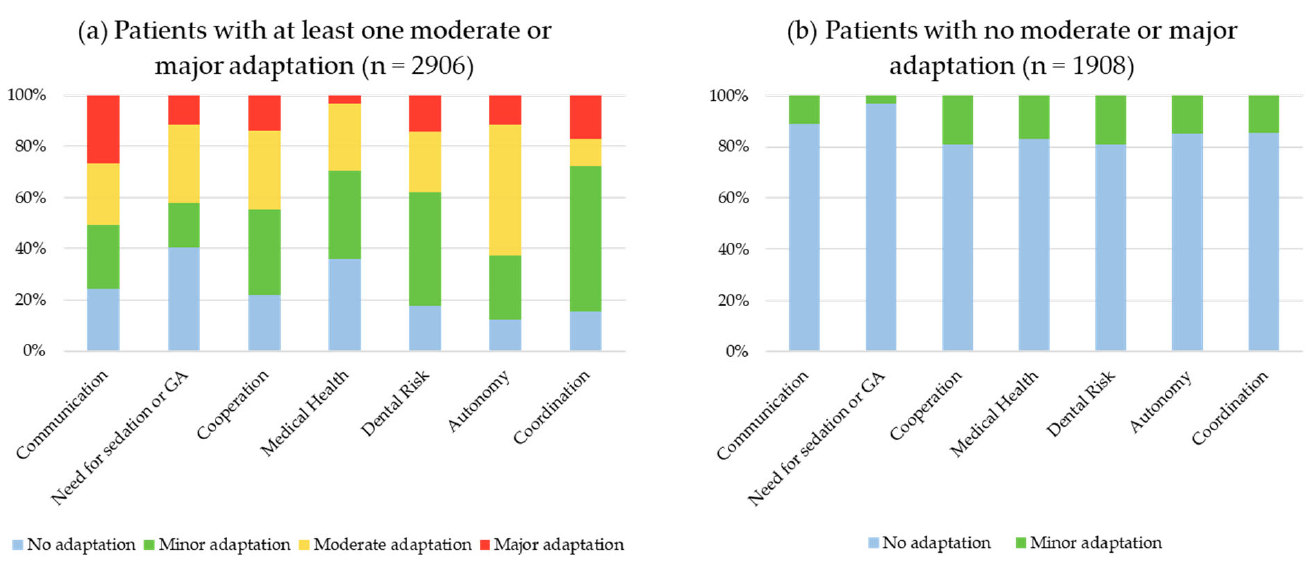
Figure 1. Figure 1 shows the distribution of scores: ( a ) distribution of scores for FCM forms with at least one moderate or major adaptation scored; ( b ) distribution of scores for FCM forms with no moderate or major adaptation